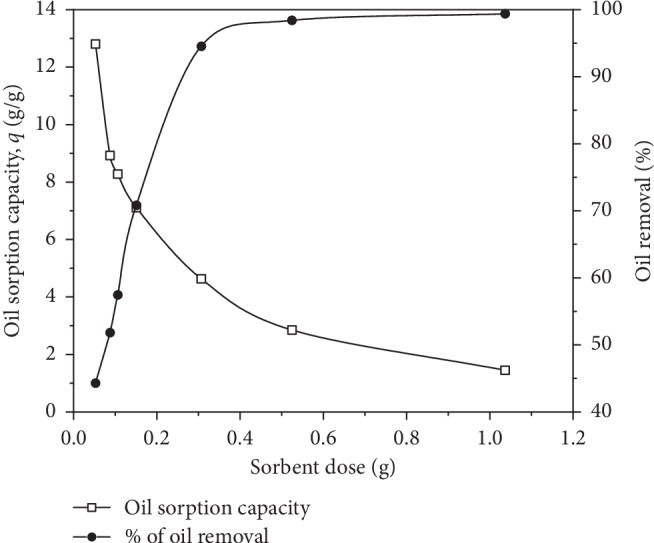
Effect of biosorbent dose on oil sorption capacity and oil removal efficiency (reaction time = 15 min, oil concentration = 30 g/L).